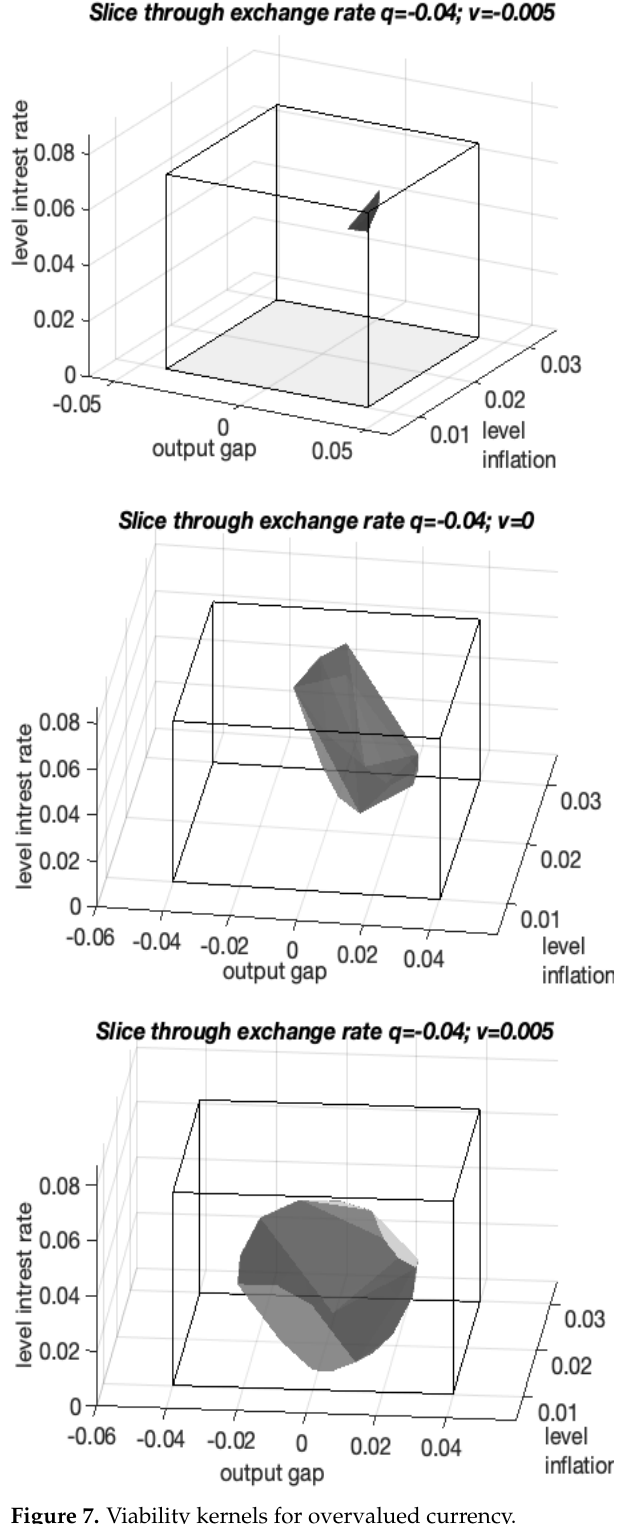
Figure 7. Viability kernels for overvalued